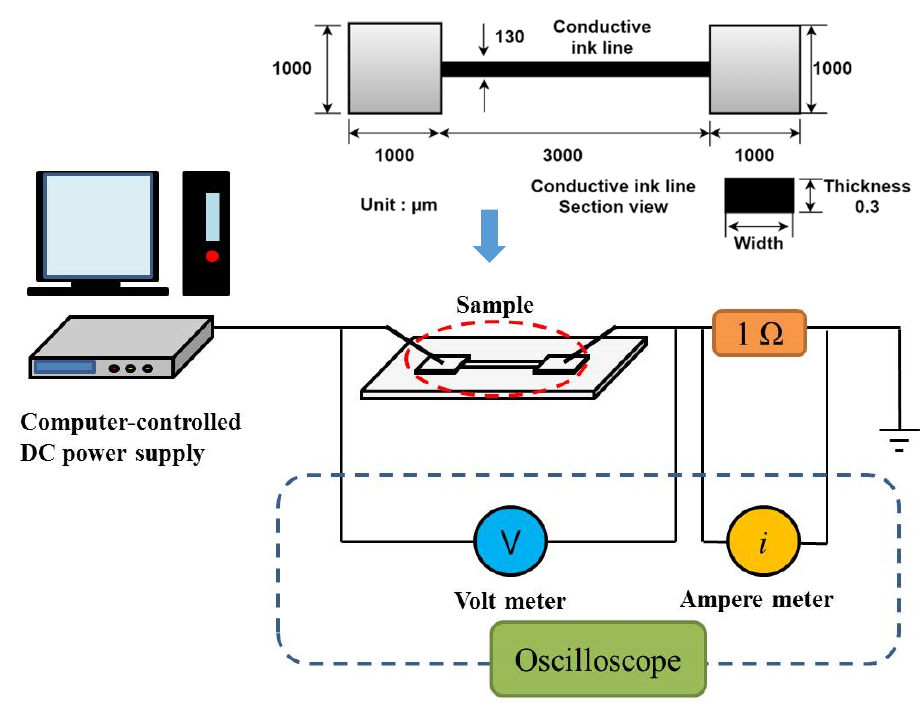
Figure 2. Schematics of the stepwise current sintering setup. The temperature calculation was carried out by solving a two-dimensional heat conduction equation using the COMSOL Multiphysics (COMSOL, Inc., District Avenue Burlington, MA, USA). The Wiedemann-Franz law was used to estimate the transient ther- mal conductivity of the Ag NP ink, which states that “The ratio of the thermal conductivity to the electrical conductivity of metal at not too low temperatures is directly proportional to the temperature [36],” and it is expressed as follows: